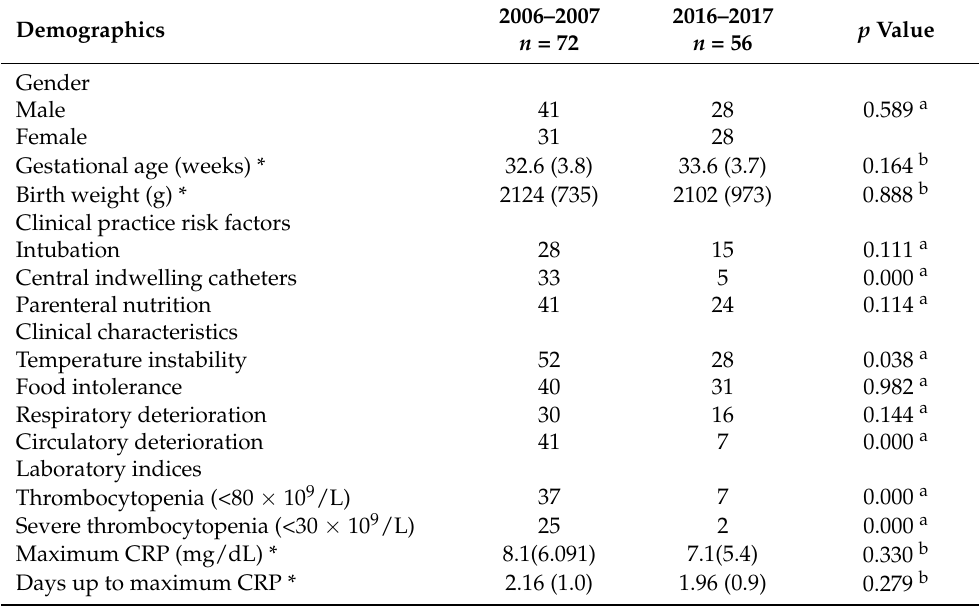
Table 2. Comparison of characteristics among neonates with CoNS bacteremias between the periods 2006–2007 ( n = 72) and 2016–2017 ( n =